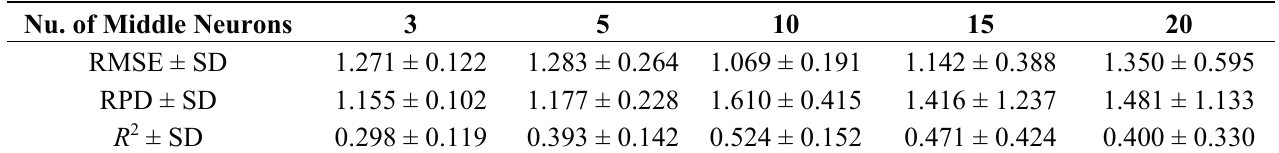
Table 7. Mean ± Standard Deviation (SD) criteria for 10 successive runs of different neural network.